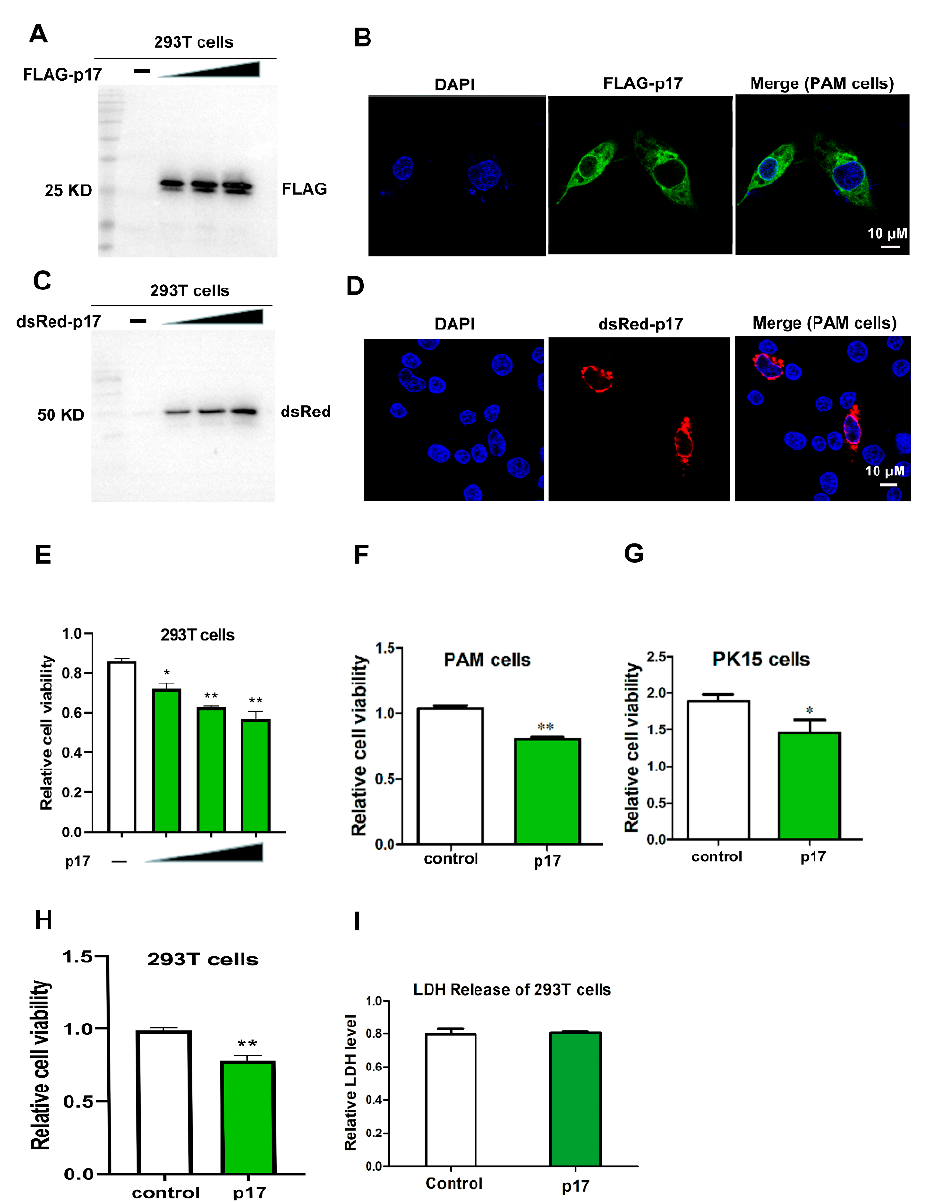
Figure 1. Detecting the expression of ASFV p17 protein in 293T and PAM cells, and effects of p17 on cell proliferation and LDH release. ( A ) Expression of FLAG-p17 protein in 293T cells was detected by Western Blot using anti-FLAG after transfection with FLAG-p17 plasmids for 24 h. The FLAG-p17 plasmids for transfection were 0.25, 0.5, and 1 µ g/mL, respectively. ( B ) Expression of FLAG-p17 protein in PAM cells by IF. ( C ) Expression of dsRed-p17 protein in 293T cells was detected by western blot using anti-dsRed after transfection with dsRed-p17 plasmids for 24 h. The dsRed-p17 plasmids for transfection were 0.25, 0.5, and 1 µ g/mL, respectively. ( D ) Expression of dsRed-p17 protein in PAM cells was detected by IF. ( E ) Effects of p17 on cell proliferation in 293T cells were analyzed with a CCK-8 kit after transfection with FLAG-p17 plasmids for 24 h. The FLAG-p17 plasmids for transfection were 0.25, 0.5, and 1 µ g/mL, respectively. ( F , G ) Effects of p17 on cell proliferation in PAM and PK15 cells were analyzed with a CCK-8 kit. The p17 groups were transfected with7 FLAG-p1 (1 µ g/mL) for 24 h. ( H ) Effect of p17 on cell proliferation in 293T was detected with an MTT assay. The FLAG-p17 plasmid for transfection was 1 µ g/mL. ( I ) Effect of p17 on LDH release in 293T cells. The p17 groups wasere transfected with FLAG-p17 (1 µ g/mL) for 24 h. Control groups were transfected with empty plasmids. Values represent the mean ± S.D; * p < 0.05, ** p < 0.01 versus the control